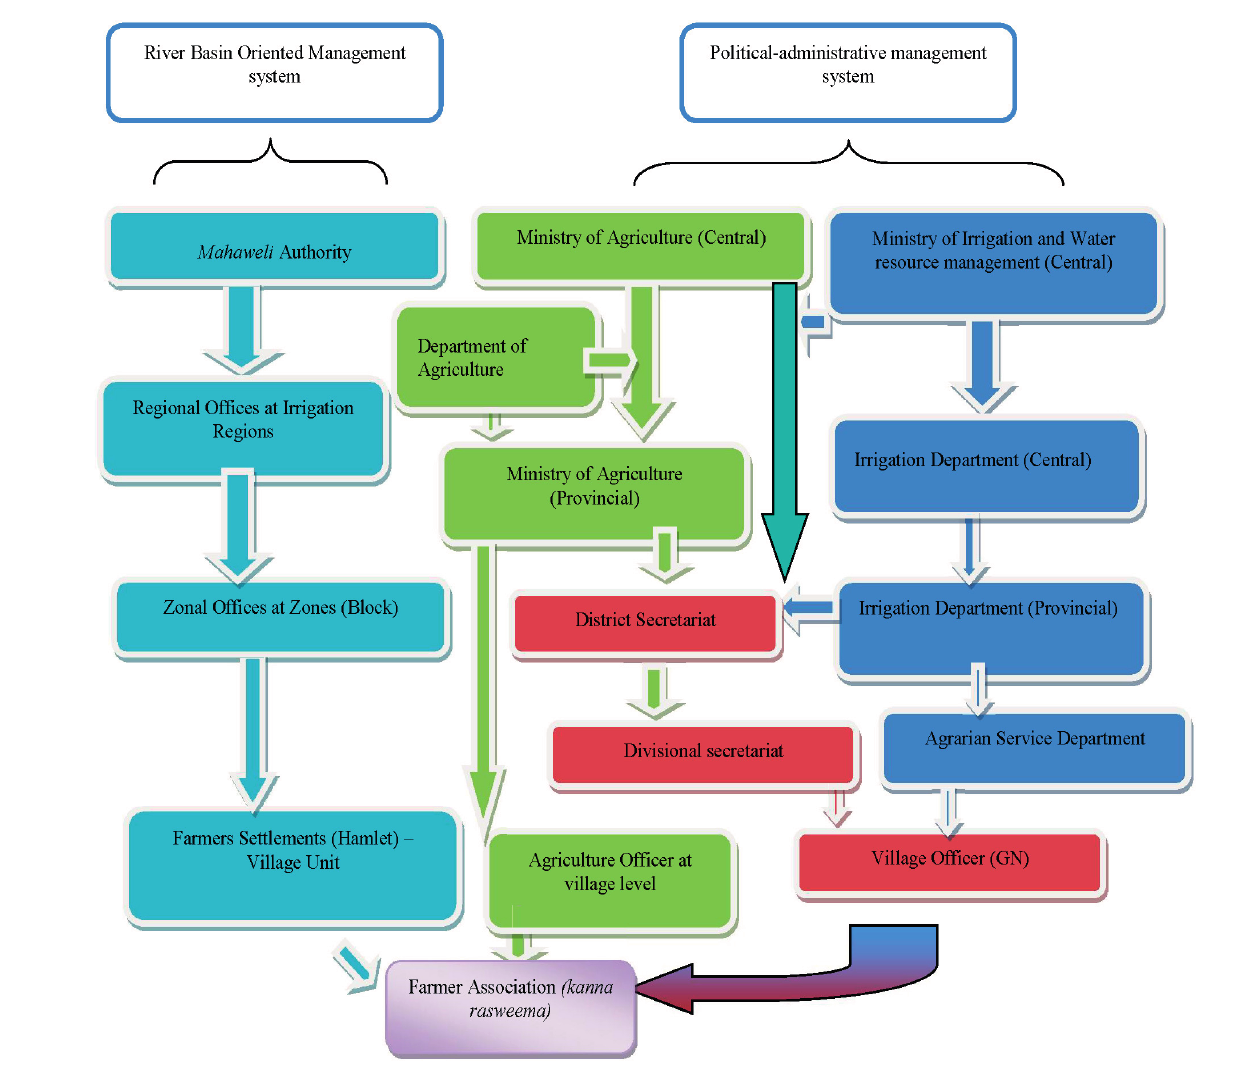
Figure 9. River basin-oriented management system and political-administrative management system in the Mahaweli River Basin area (authors’